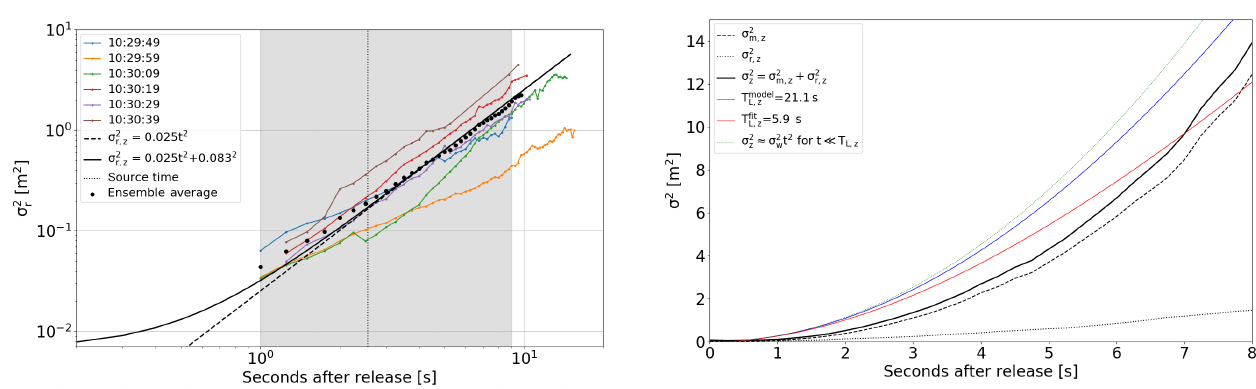
Figure 13. Relative dispersion in the vertical on a log–log scale. The coloured curves show the dispersion of individual puffs and the black points show the ensemble average over these individual puffs. The source size was estimated by a linear fit to the ensemble average (dashed black line). The resulting source size was used to calculate the predicted curve by Eq. (4) (solid line) and estimate the source time (dotted black line).